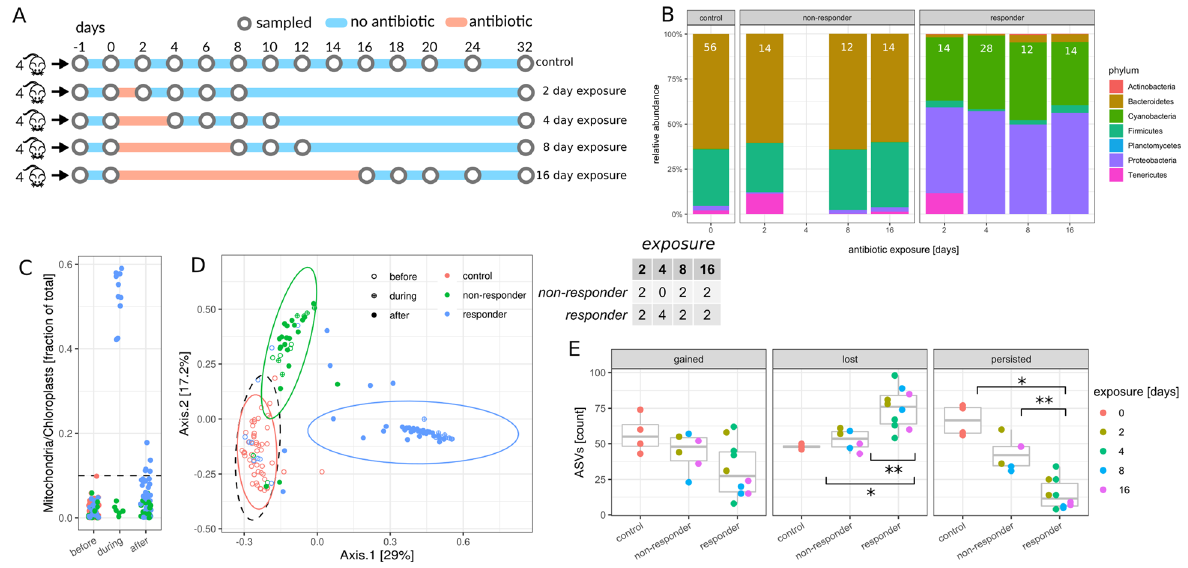
Fig. 1 Effect of antibiotic exposure duration on non-responder phenotype. The table in the center denotes the number of non-responder and responder mice in each treatment duration group. A Experimental design for the duration experiment. Circles denote sampled time points. Time points were considered sampled “ during ” antibiotic treatment between day 0 and day 2, 4, 8, and 16, respectively, as denoted by orange shades. B Relative abundance of phyla on the last day of antibiotics treatment. The control panel is an average over all untreated controls from all time points. Only phyla with a relative abundance of at least 0.1% are shown. Each barchart denotes means from at least two samples and white insets are the sample size used for each barchart. C Percentage of mitochondria and chloroplast sequences in 16S amplicon data relative to antibiotic treatment. Colors: red — controls not treated with antibiotics, green — non-responders, blue — responders. D Principal coordinate analysis (PCoA) of samples during and after antibiotic exposure ( n = 143 samples with >10,000 reads per sample, day ≥ 0). Ellipses denote 95% con fi dence intervals from a Student t -distribution. Each point denotes a sample. ASV abundances were rare fi ed to 10,000 reads for each sample and percentages in brackets denote the explained variance. Samples with less than 10,000 reads per sample were not included in the analysis. E Dynamics of amplicon sequence variants (ASVs). Gained ASVs are variants that were not present before antibiotics treatment but are present after. Similarly, lost ASVs were present before treatment but not after, and persistent ASVs were present before and after. Stars denote signi fi cance under a Mann – Whitney U test: * p < 0.05, ** p <